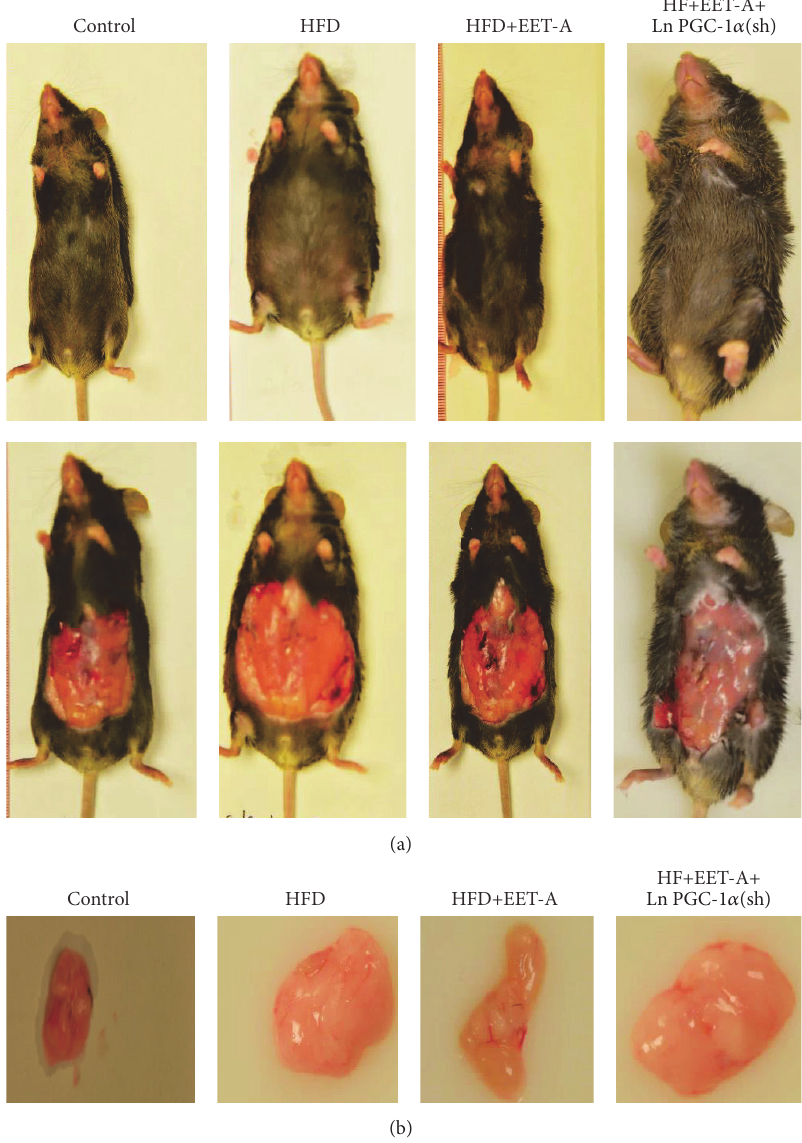
Figure 2: Appearance of (a) body and (b) fat size of mice during a period of 8 weeks on high fat